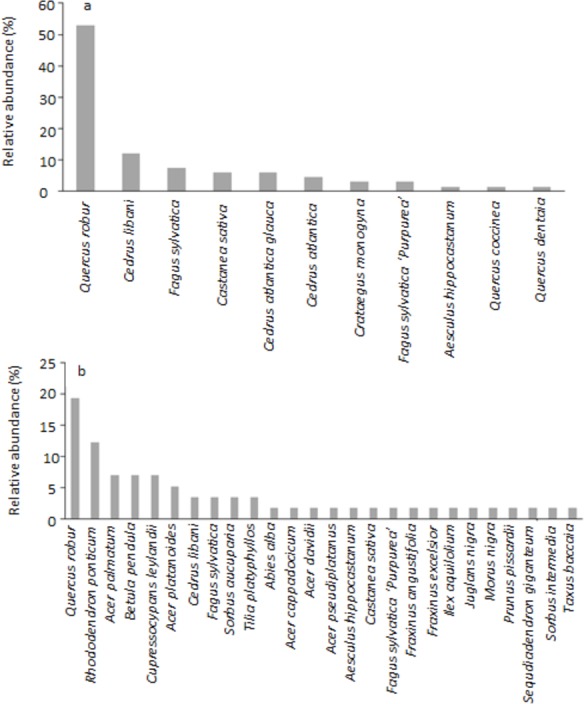
Relative abundance (%) of trees in (A) the North Front parkland and (B) the West Garden.